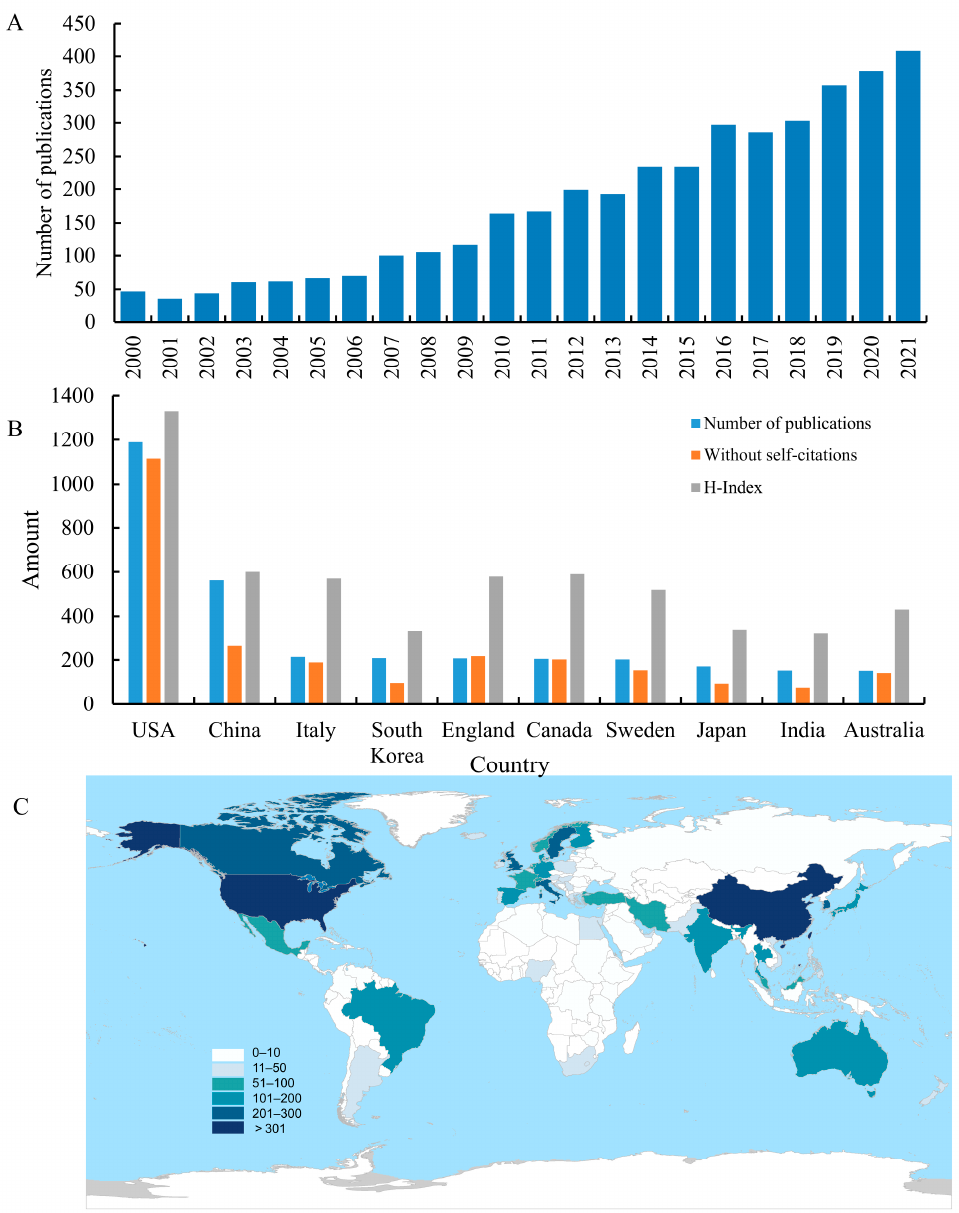
Figure 1. Evolution of publications and contributions of different countries/regions. ( A ) Annual changes in the number of publications. ( B ) Number of publications, without self-citations (actual value/60), H-index (actual value × 10). ( C ) Regional clustering characteristics of